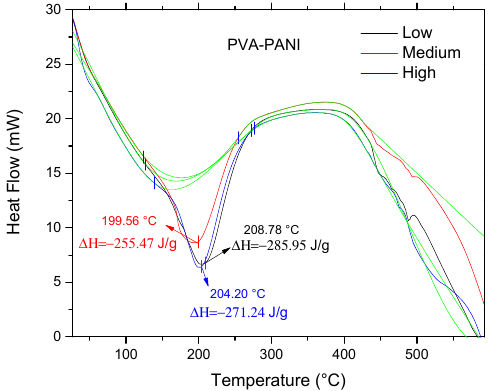
Figure 12. DSC of purified PVA–PANI gels at low, medium, and high concentrations of PANI.